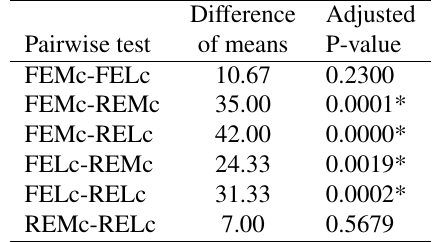
Table 15. Tukey Test Results for DAP-TC ( π SP is